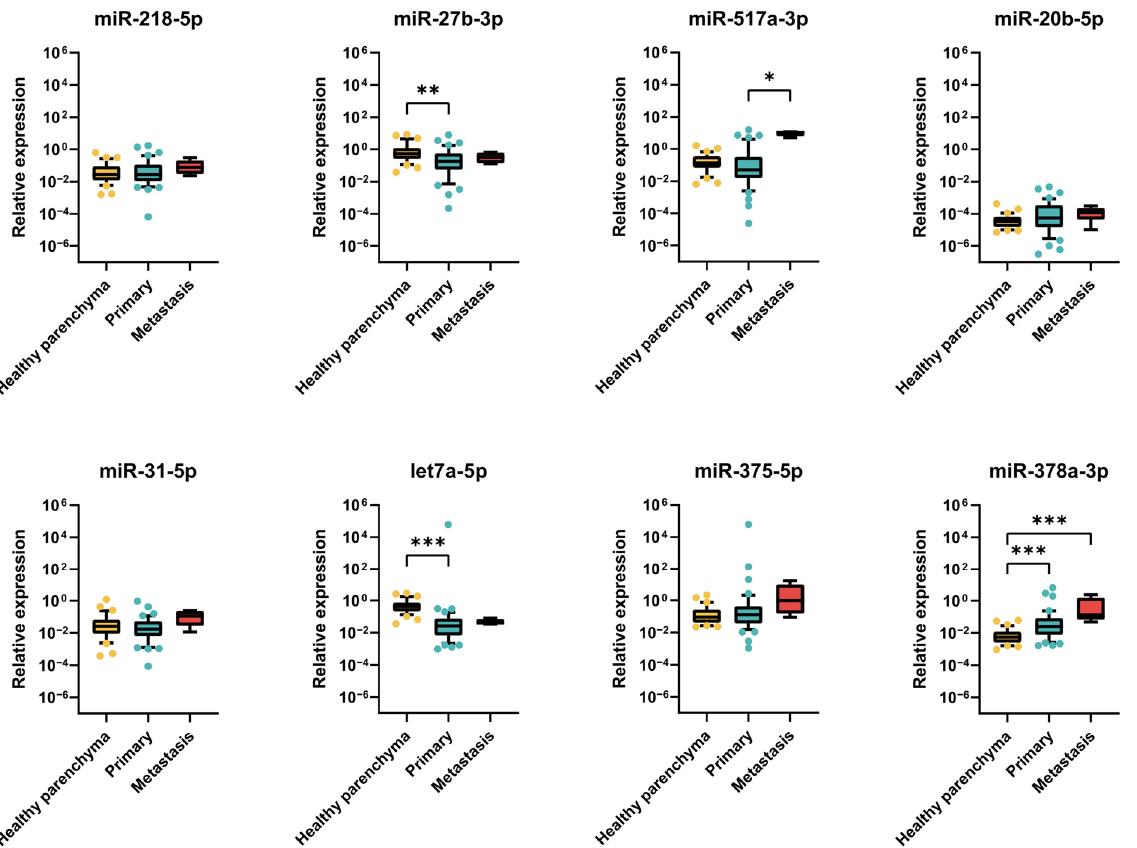
Figure 5. Expression of miRNAs in patient tumour samples. Boxplots show relative miRNA expression (2 −Δ Ct ) of miR-218-5p, miR-27b-3p, miR-517a-3p, miR-20b-5p, miR-31-5p, let-7a-5p, miR-375-5p and miR-378a-3p in primary tumour ( n = 48), metastatic ( n = 5) and control (normal parenchyma, n = 33) samples. Data are presented as medians with interquartile ranges. Whiskers show 10–90 percentile. * p ≤ 0.05, ** p ≤ 0.01, *** p ≤ 0.001.